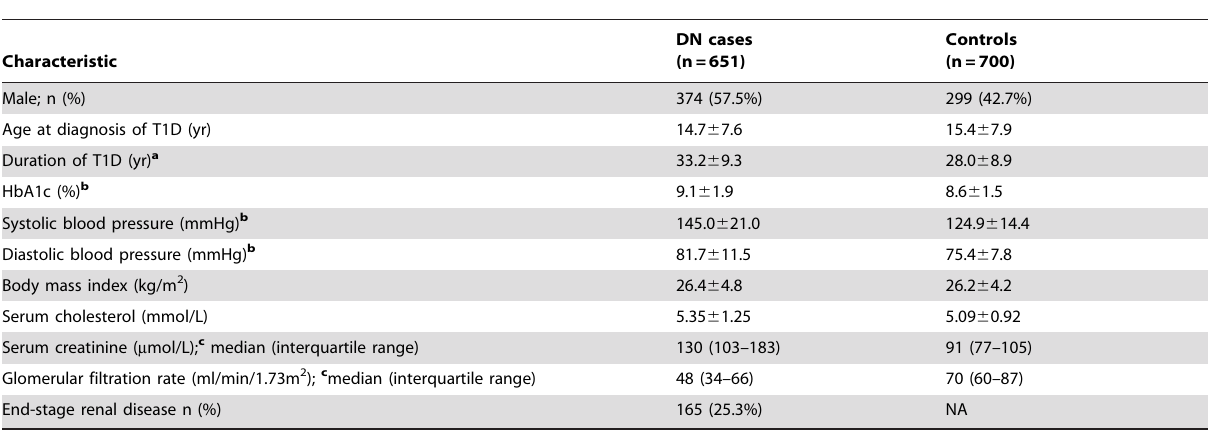
Table 1. Clinical characteristics of diabetic nephropathy (DN) cases and diabetic controls.